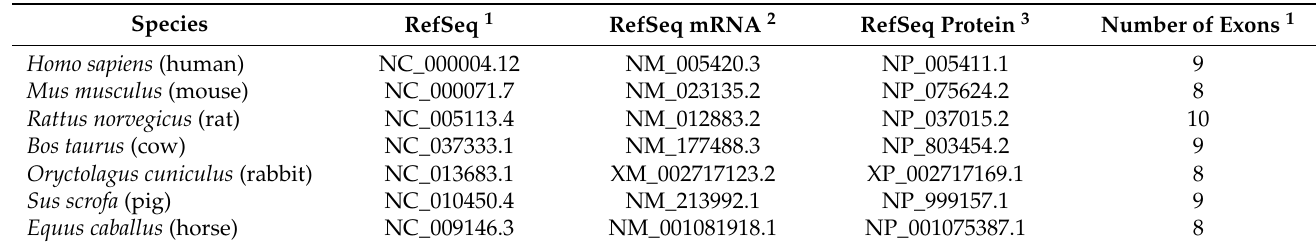
Table 2. SULT1E1 expression in other mammalian